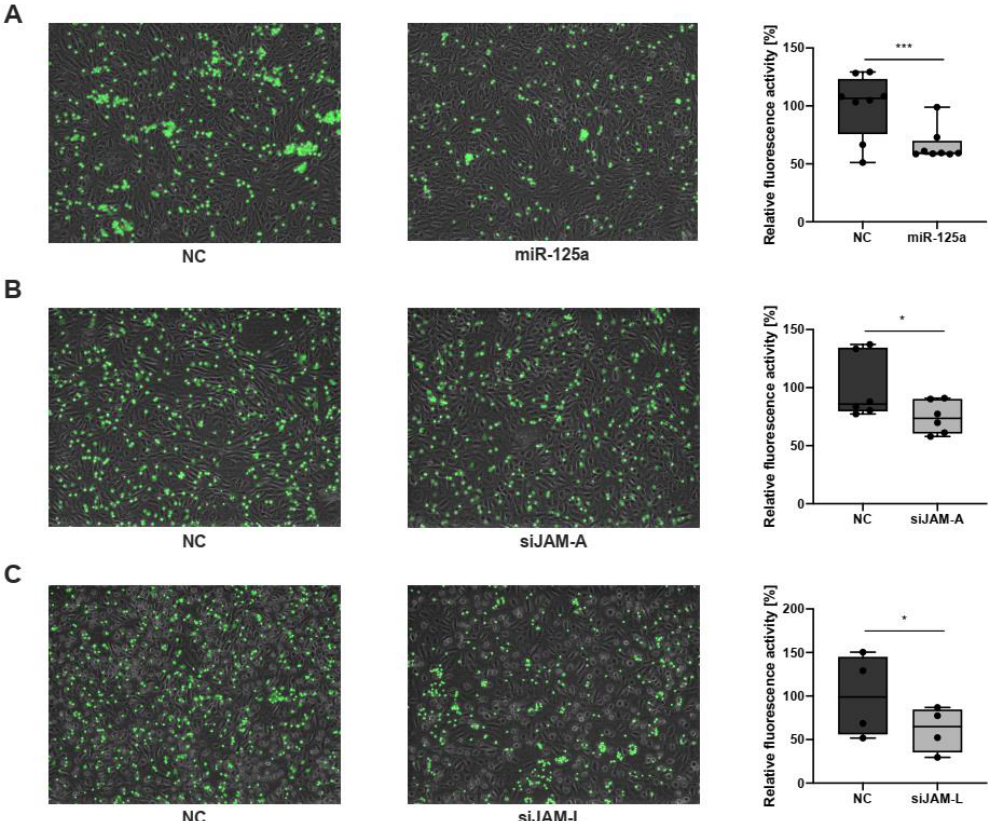
Figure 3. Overexpression of miR-125a and JAM-A/JAM-L knockdown reduces the adhesion of primary human monocytes to inflammatory endothelial cells . ( A ) Calcein-stained adherent monocytes transfected with negative control (NC) or miR-125a. Cells were perfused across HUVECs activated with TNF- ɑ . After perfusion and fluorescence microscopy, cells were harvested, and fluorescence intensity was measured (n = 8, *** p < 0.001). ( B , C ) Calcein-stained adherent monocytes transfected with negative control (NC) or siRNA targeting either JAM-A (n = 6, * p < 0.05) or JAM-L (n = 4, * p < 0.05).